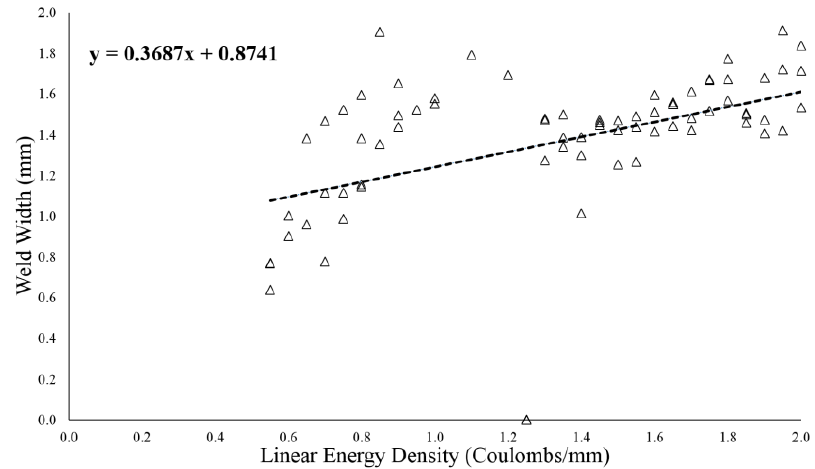
Figure 5. Weld width as a function of linear energy density for 10 mm/s on two layers of LLDPE.